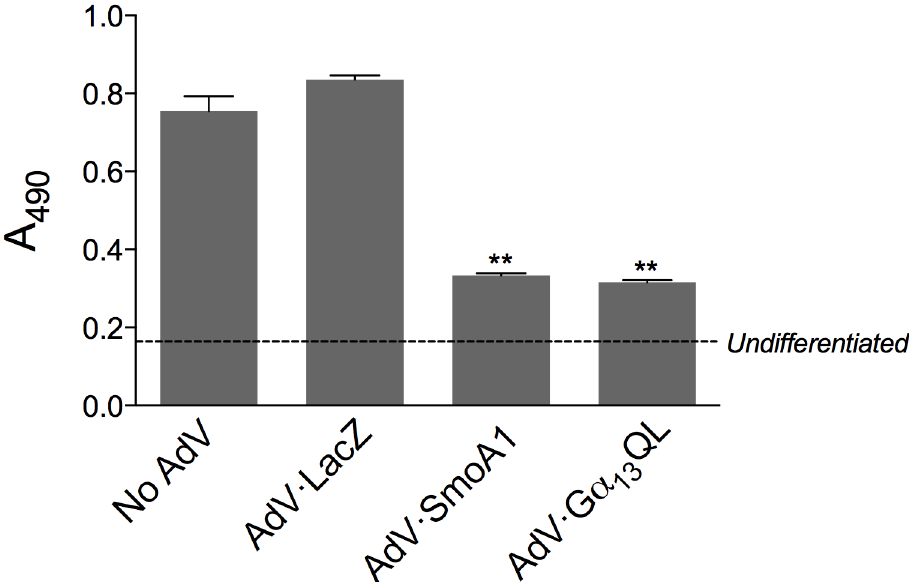
Fig 5. Effect of SmoA1 and G α 13 QL on 3T3-L1 adipogenic differentiation. 3T3-L1 fibroblasts were transduced with recombinant adenoviruses encoding with LacZ, SmoA1, or G α 13 QL (MOI of 10), or no virus, in the presence of DEAE-dextran (10 μ g/ml). The medium was replaced, and the cells were induced to differentiate with a combination of IBMX (0.5 mM), dexamethasone (0.25 μ M), rosiglitazone (2 μ M), and insulin (1 μ g/ml) as described in ‘Materials and Methods’. The cells were fixed at 2 weeks, and triglyceride accumulation was evaluated with Oil Red O. The data shown are from one experiment representative of three total, each carried out in triplicate, ± SEM; (cid:3)(cid:3) , p < 0.01 relative to LacZ. ‘Undifferentiated’ refers to the absorbance for cells not induced to differentiate. For the three experiments, the average A 490 for SmoA1 and G α 13 QL relative to that for untransformed differentiated cells, subtracting the absorbance for undifferentiated cells, was 0.1 ± 0.07 for both SmoA1 and G α 13 QL (p <